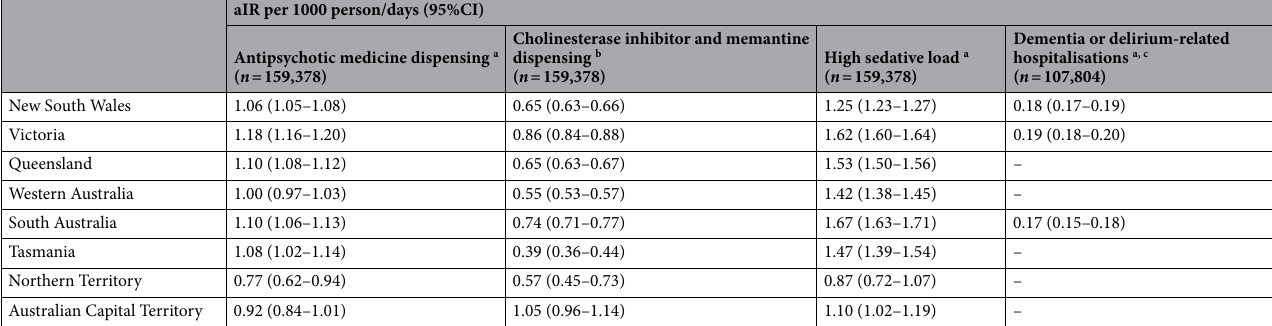
Table 4. Adjusted incidence rate of clinical quality indicator performance by state, 2015–2016. aIR Adjusted incidence rate, CI Confidence interval. a Adjusted for sex and age at 1 July 2015. b Adjusted for sex, age at 1 July 2015, and time since cohort entry. c New South Wales, Victoria, and South Australia